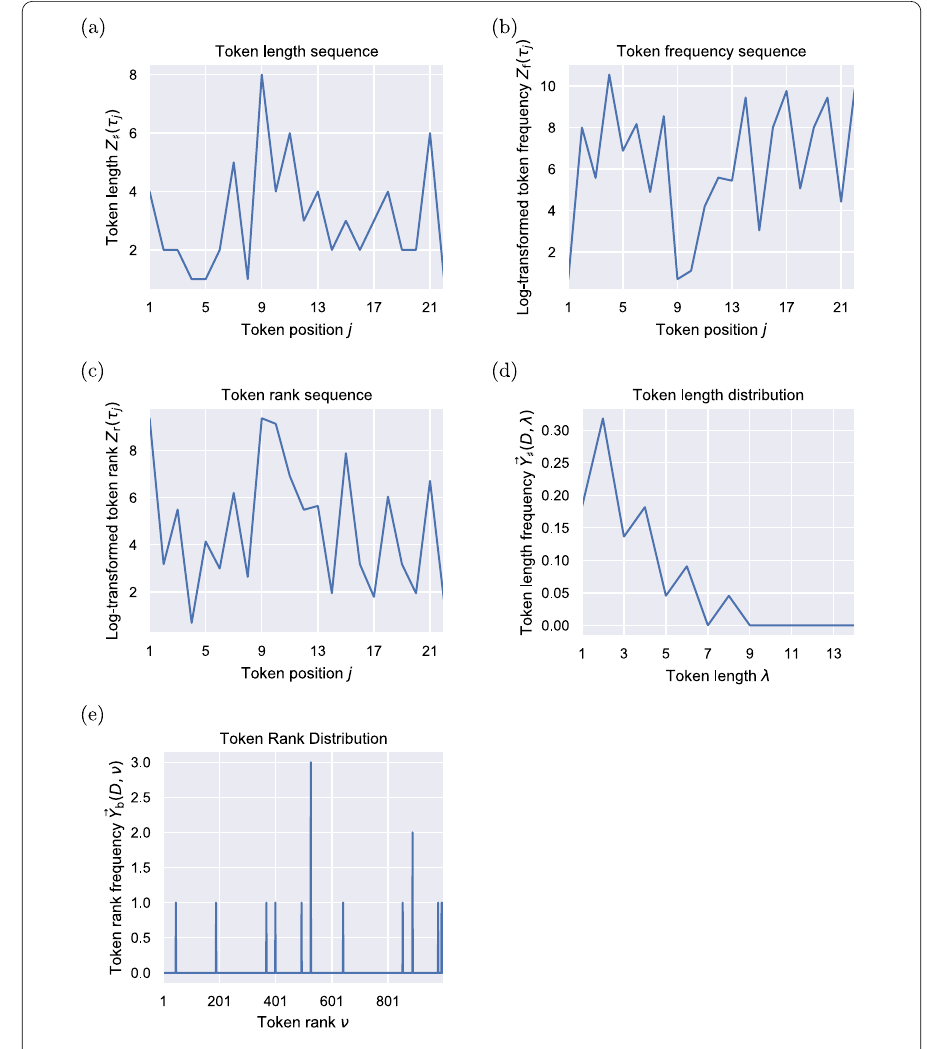
Figure 3 An overview of the five functional language sequences mapped from the sample text (p. 13) by five different functional language sequence mapping methods